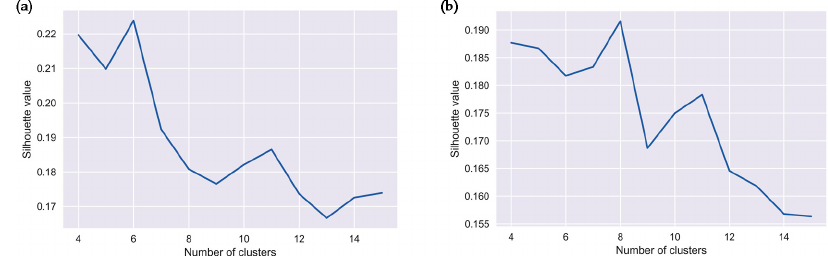
Figure 4. Silhouette metric values and number of clusters for: ( a ) salmonellosis, A02.8, and ( b ) enteritis, A04.9 in Barnaul, Russia in 2004–2011.